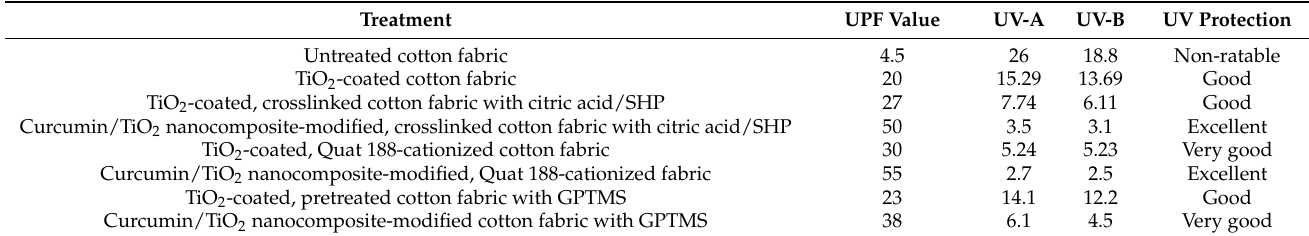
Table 2. UPF values of cotton fabric treated with different conditions. Treatment